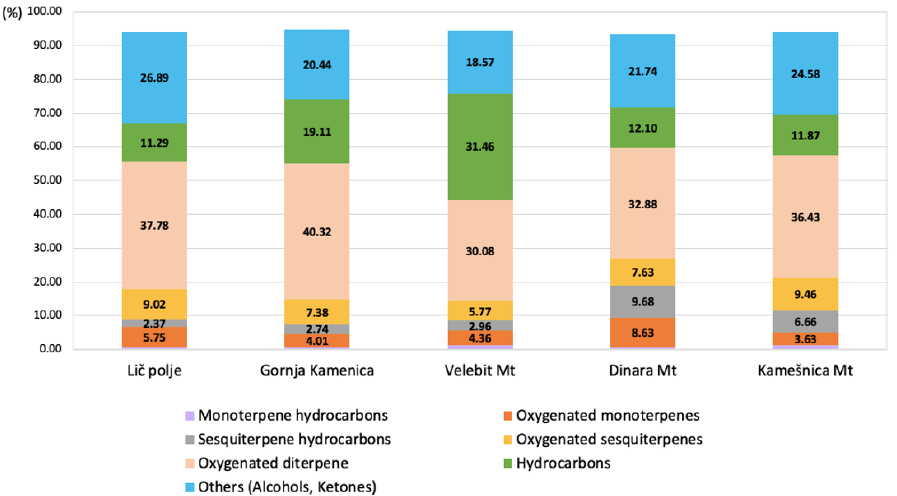
Figure 4. Volatile compounds distribution by categories of Barrelier’s Speedwell EOs from five locations.